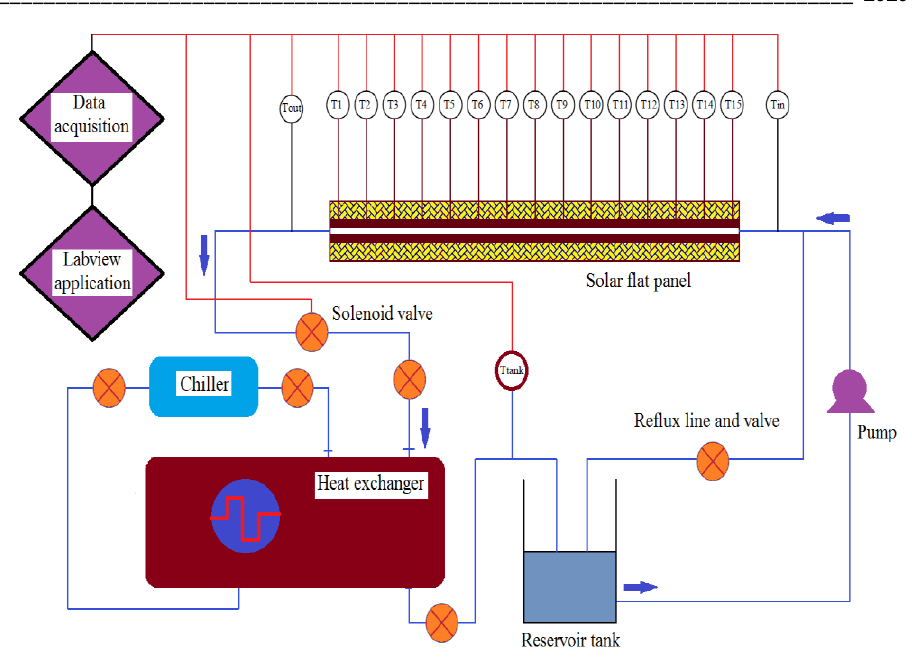
Fig. 7. Experimental setup for the measurement of convective heat transfer coefficient